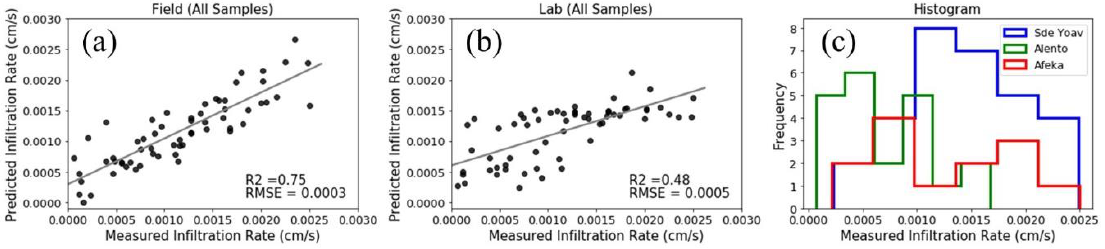
Figure 7. The results of the PLSR model of the field-based dataset ( a ) and the lab-based dataset ( b ) using the 450–2400 nm spectral range; ( c ) histogram of the measured infiltration rate values at different study areas.